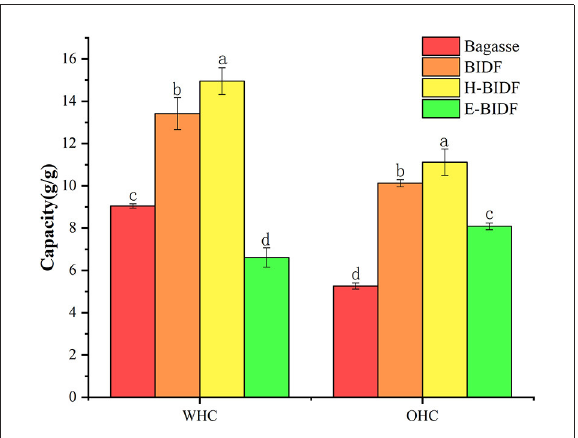
FIGURE6 The WHC and OHC of bagasse, BIDF, H-BIDF and E-BIDF. Different letters (a, b, c, d) denote significantly different in the column ( p <